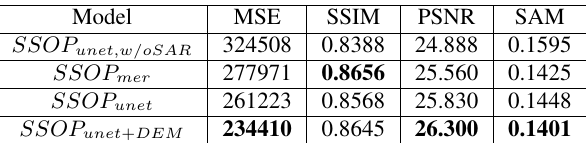
Table 7. Comparison of SSOP networks performed on the SSOP dataset